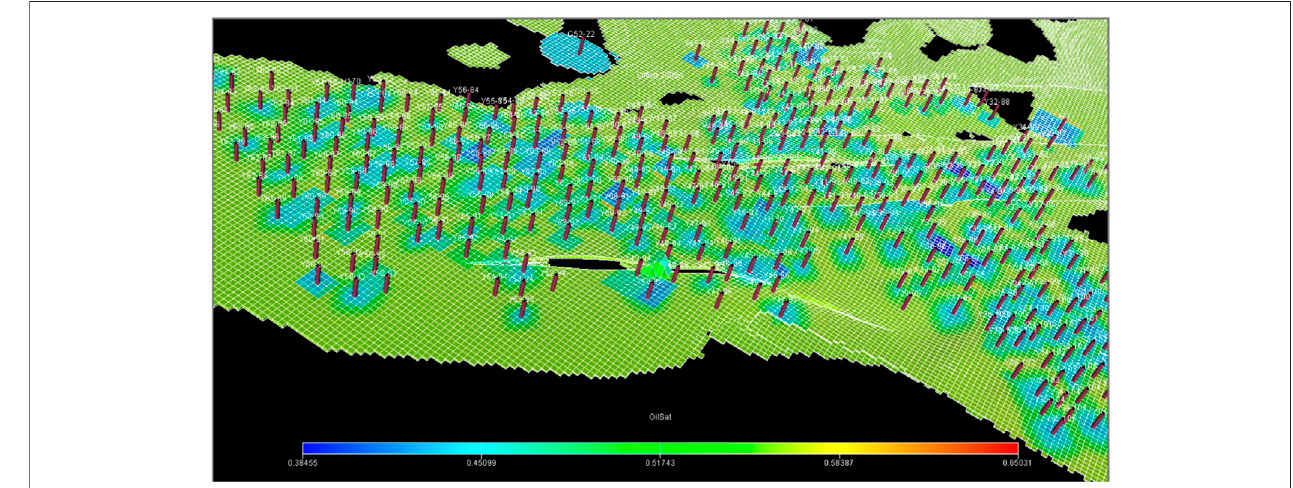
FIGURE 5 | Current remaining oil saturation distribution in the study area.